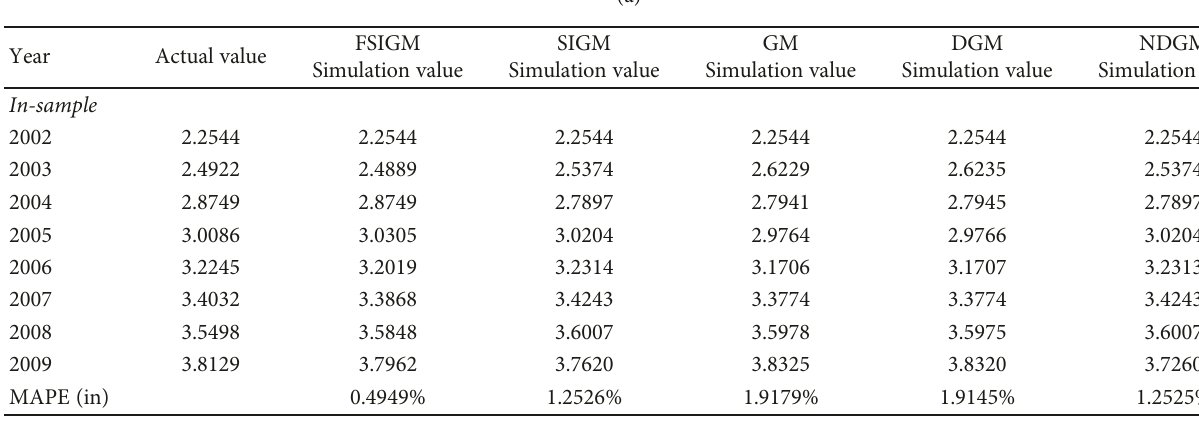
Table 2: The simulation/prediction values and MAPE of the models for China ’ s crude oil consumption. (a)